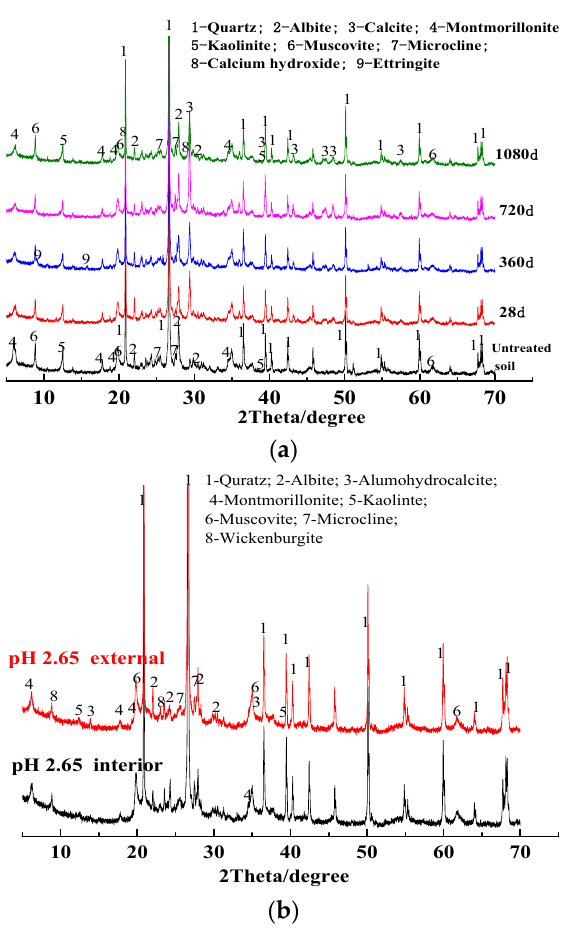
Figure 5. XRD analysis of the untreated soil and S/S samples cured in simulated scenarios for different periods: ( a ) untreated contaminated soil and samples soaked in pH 6.86 leachants for different periods; ( b ) interior and external parts of cylindrical S/S product soaked in pH 2.65 conditions.